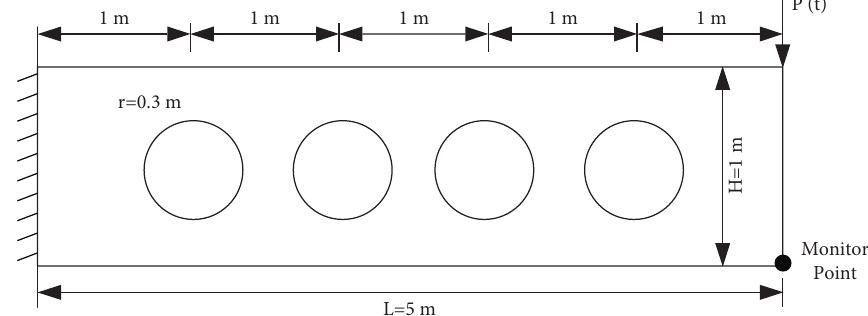
Figure 13: Geometry and boundary conditions of a multihole panel subject to a concentrated dynamic loading.